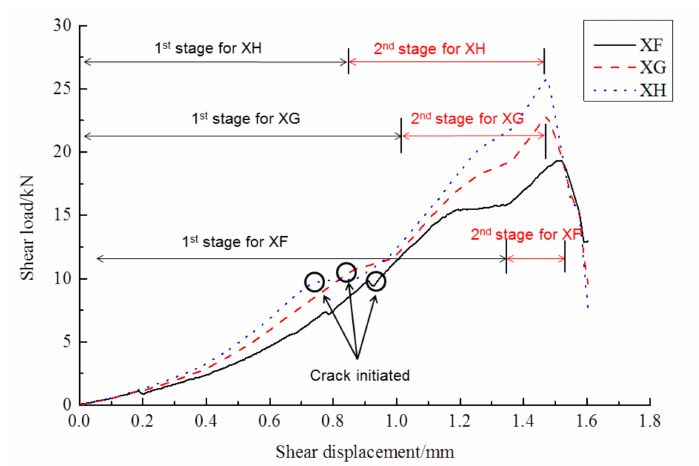
Figure 2. Shear load–displacement curves without frost damage.